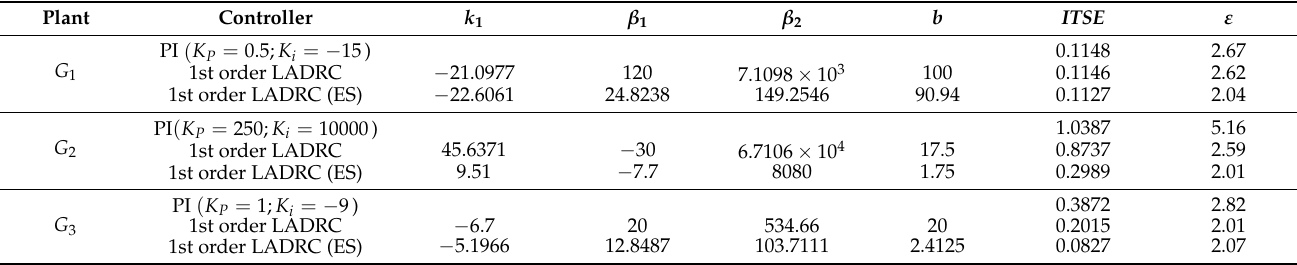
Table 1. Parameters and performance of designed controllers.